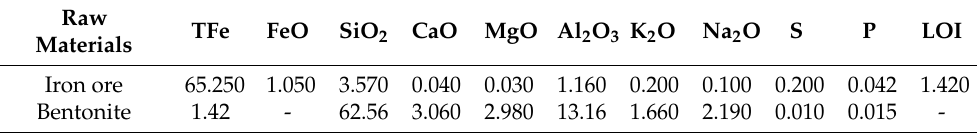
Table 1. Chemical compositions of iron ore and bentonite (mass percent, %).